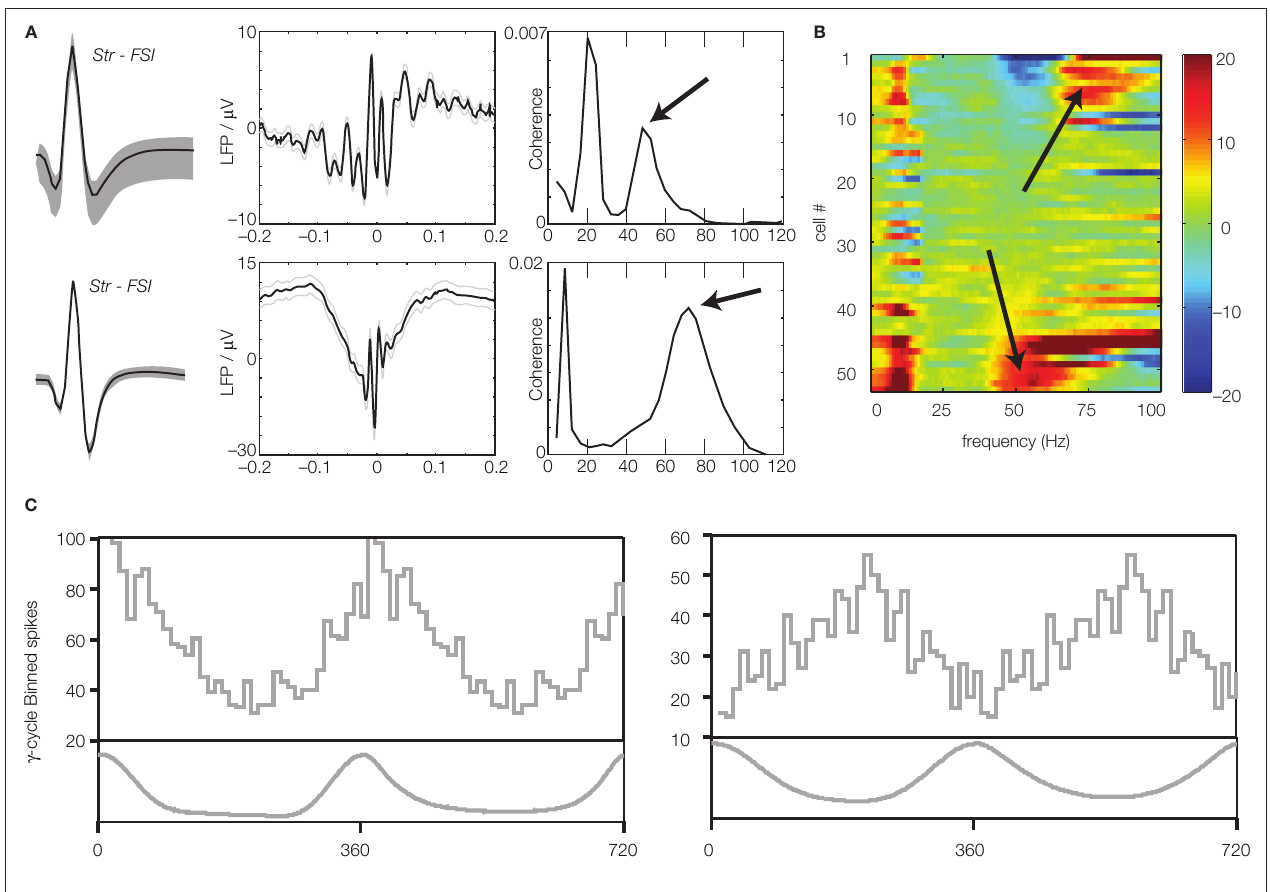
population of putative FSIs (B) finding subgroups of gamma-50 and gamma-80 coherent neurons. Plot shows the z -scored difference of the observed spike-field coherence relative to a set of interspike-interval-shuffled controls; high z -scores (hot colors) indicate high coherence. Note the two distinct populations at the top (gamma-80) and bottom (gamma-50; arrows). (C) Phase histograms for two example putative medium-sized spiny neurons (MSNs) in Kalenscher et al. (2010), showing a tendency to fire at a particular phase of the gamma